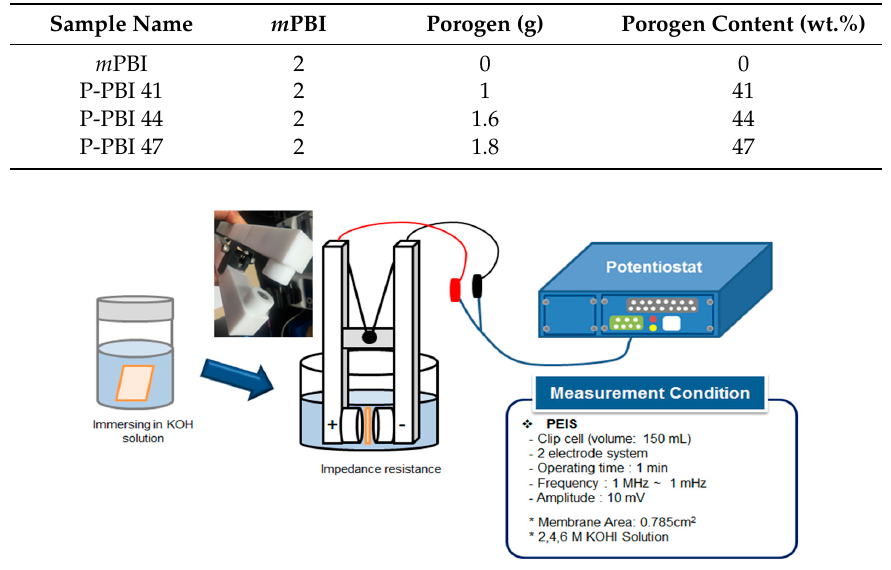
Figure 1. Clip cell for the measurement of impedance resistance.